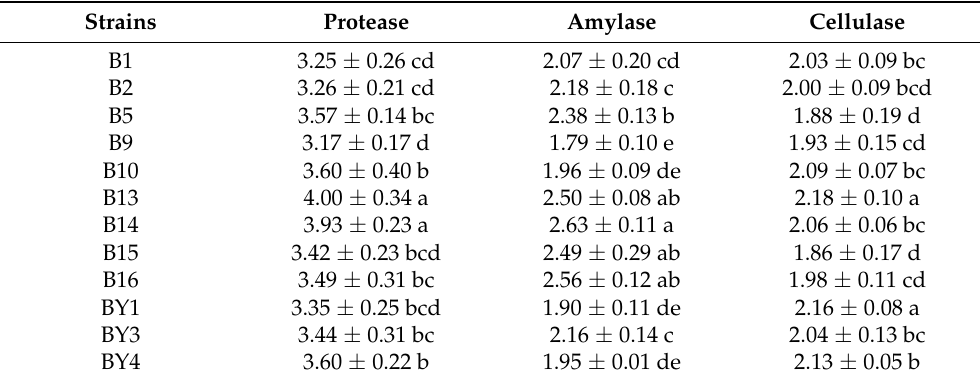
Table 2. Production capacities of three enzymes secreted by strains (expressed by the ratio of transparent circle diameter to bacterial circle diameter).